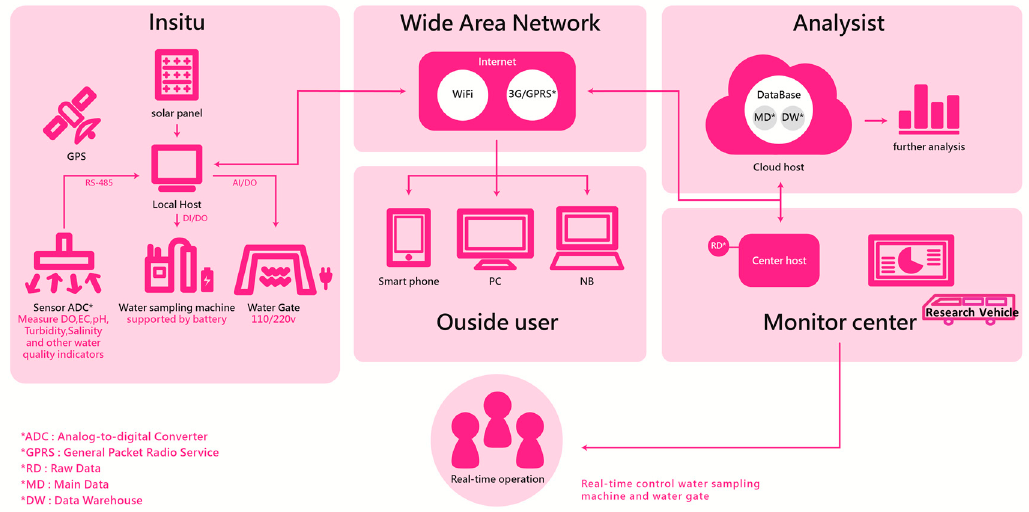
Figure 3. Conceptual framework of the agricultural environmental protection system.